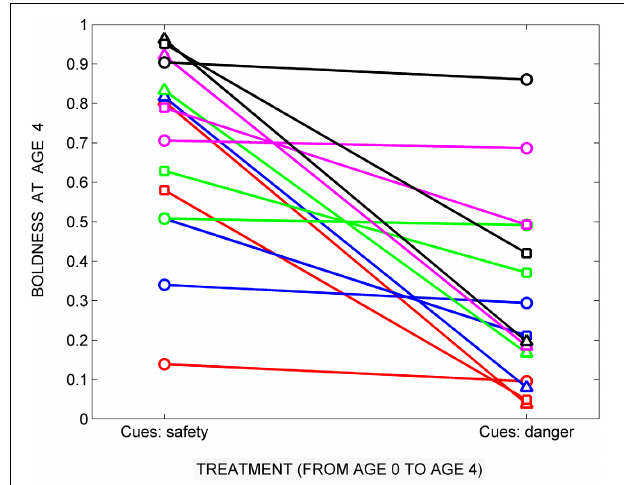
FIGURE 6 | A hypothetical common garden experiment showing how exposure to cues in two different rearing treatments might affect the boldness of 15 genotypes (replicate individuals). Genotypes with the prior distributions specified by the symbols in Figure 2 are either raised with cues indicative of safety (see Figure 2 ) or with cues indicative of danger (see Figure 3 ). The mean boldness scores at age 4 are compared for the two treatment groups. Realized developmental plasticity is lowest for genotypes whose prior distributions had low variance (circles), intermediate for genotypes whose prior distributions had intermediate variance (squares) and highest for genotypes whose prior distributions had high variance